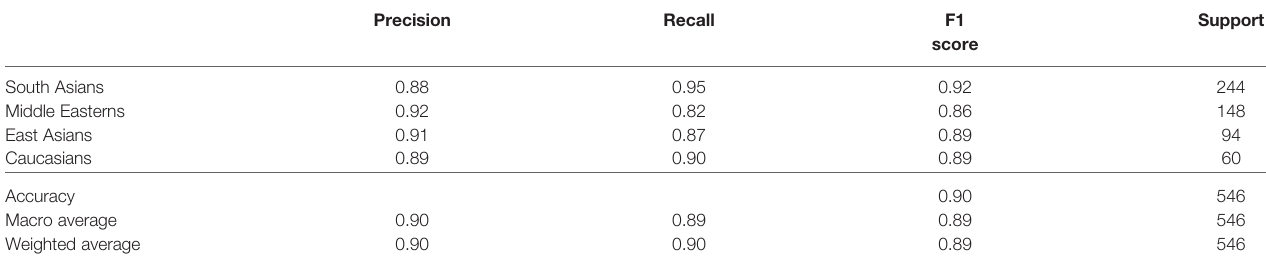
TABLE 7 | Classi fi cation metrics of neural network model.